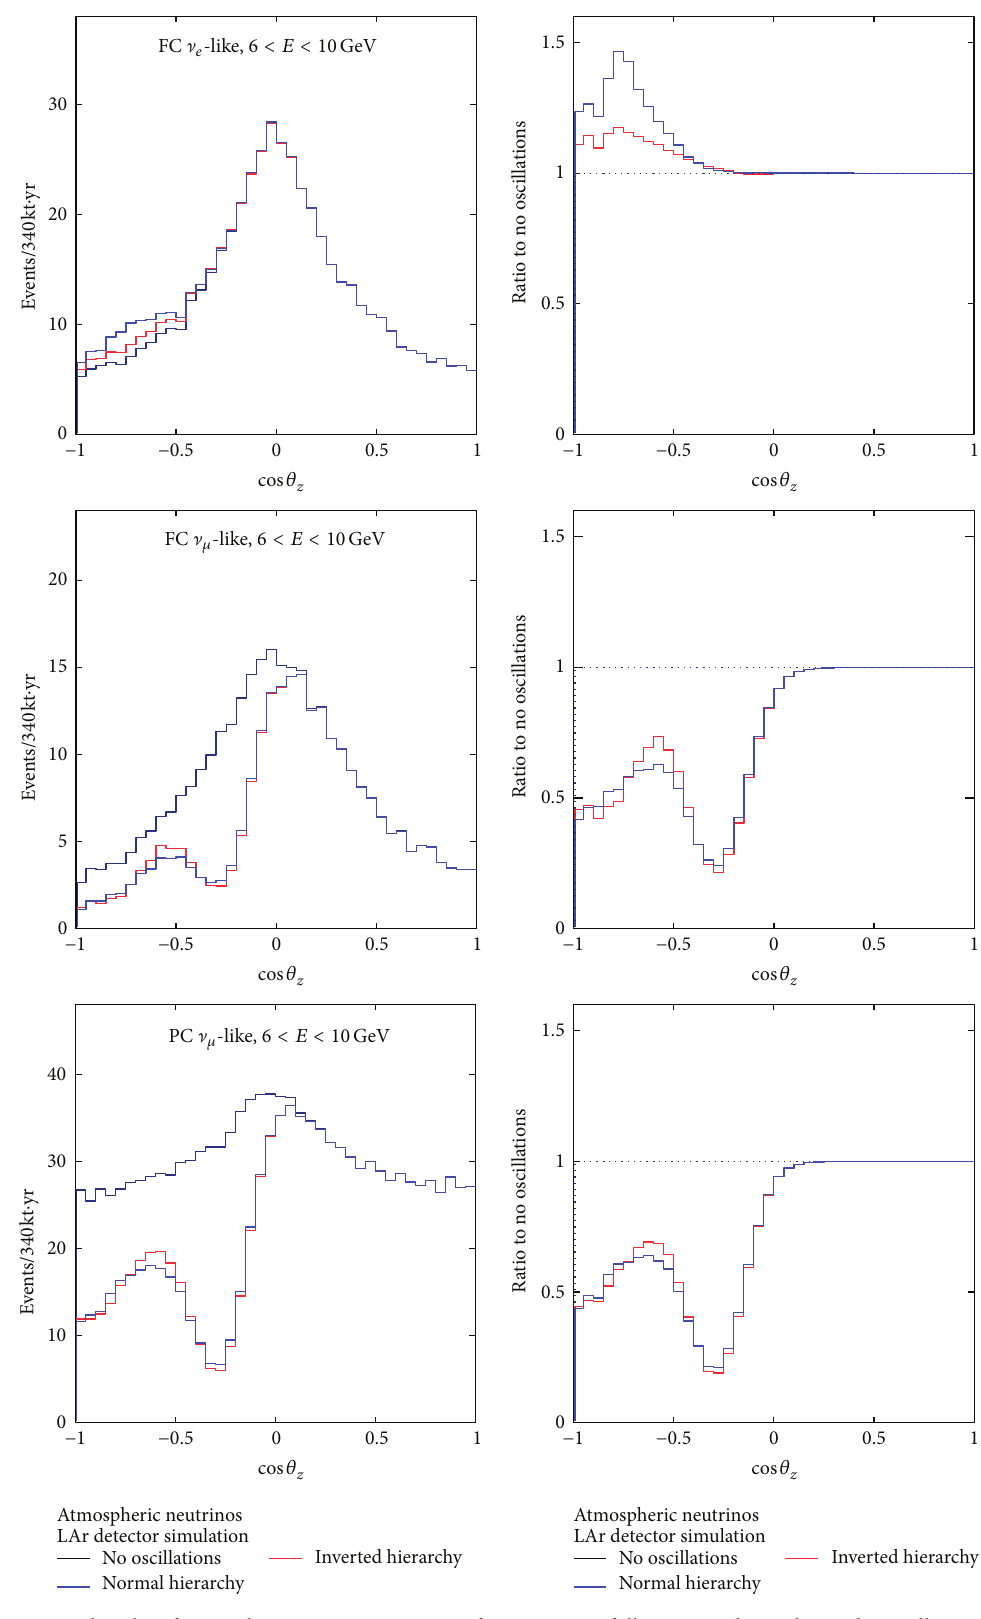
Figure 7: Reconstructed angles of atmospheric neutrinos in DUNE for 6 to 10GeV fully contained ] 𝑒 and ] 𝜇 and partially contained ] 𝜇 events. Distributions and ratios to the no oscillation case are shown for normal and inverted mass